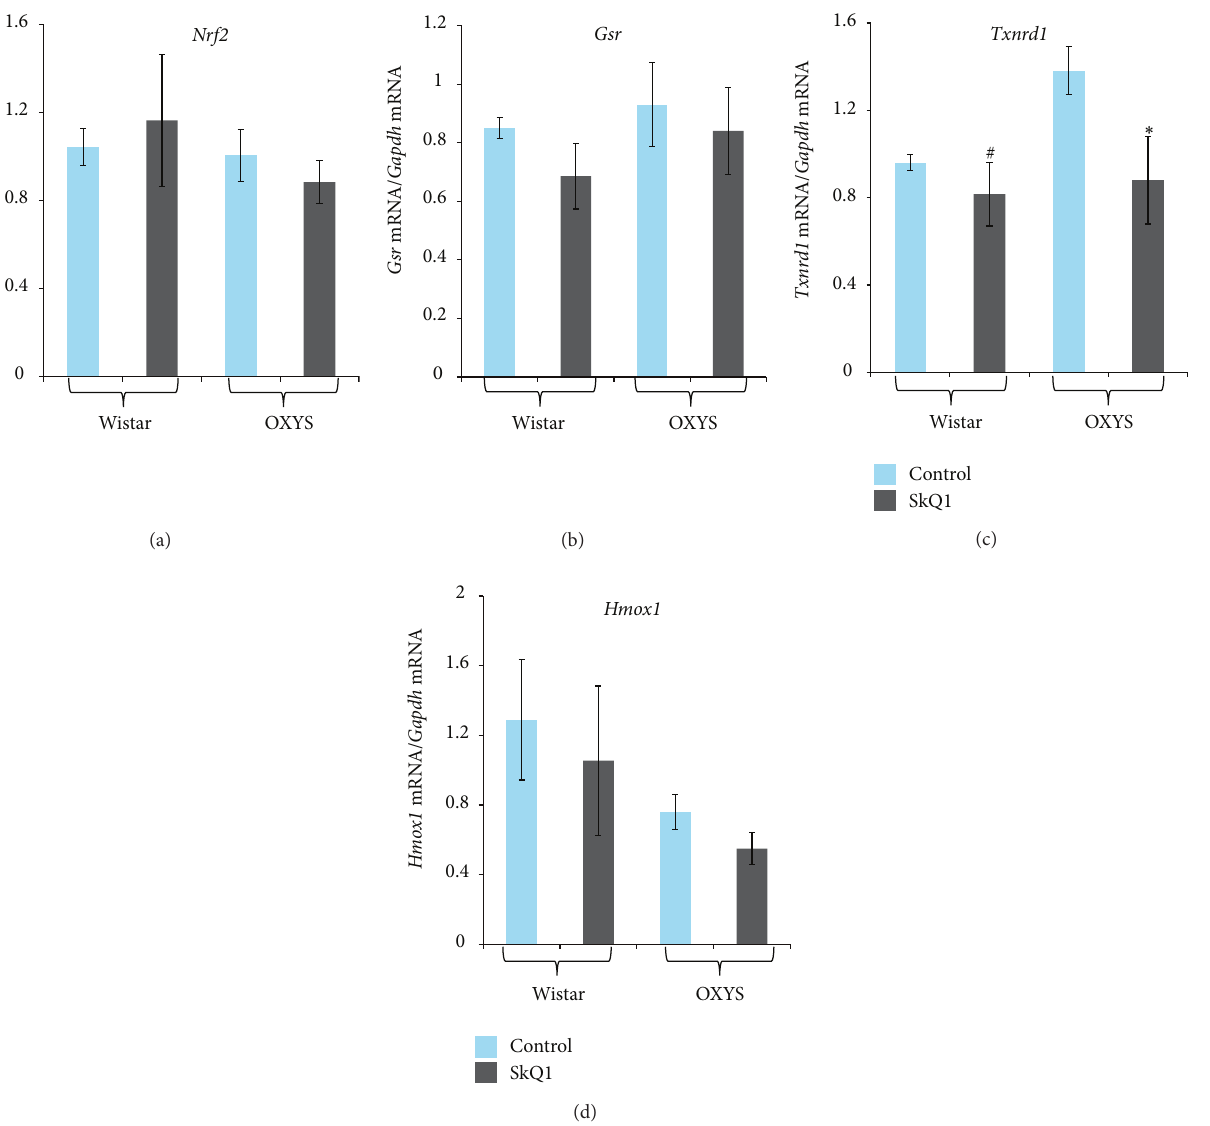
Figure 3: Nrf2 (a), Gsr (b), Txnrd1 (c), and Hmox1 (d) mRNA levels in the retinas of 3-month-old Wistar and OXYS rats treated with SkQ1. All data are normalized to the expression level of a housekeeping gene ( Gapdh ). Values are presented as mean ± SEM ( 𝑛 = 6 to 8). Significant differences between groups are marked with ∗ 𝑃 < 0.05